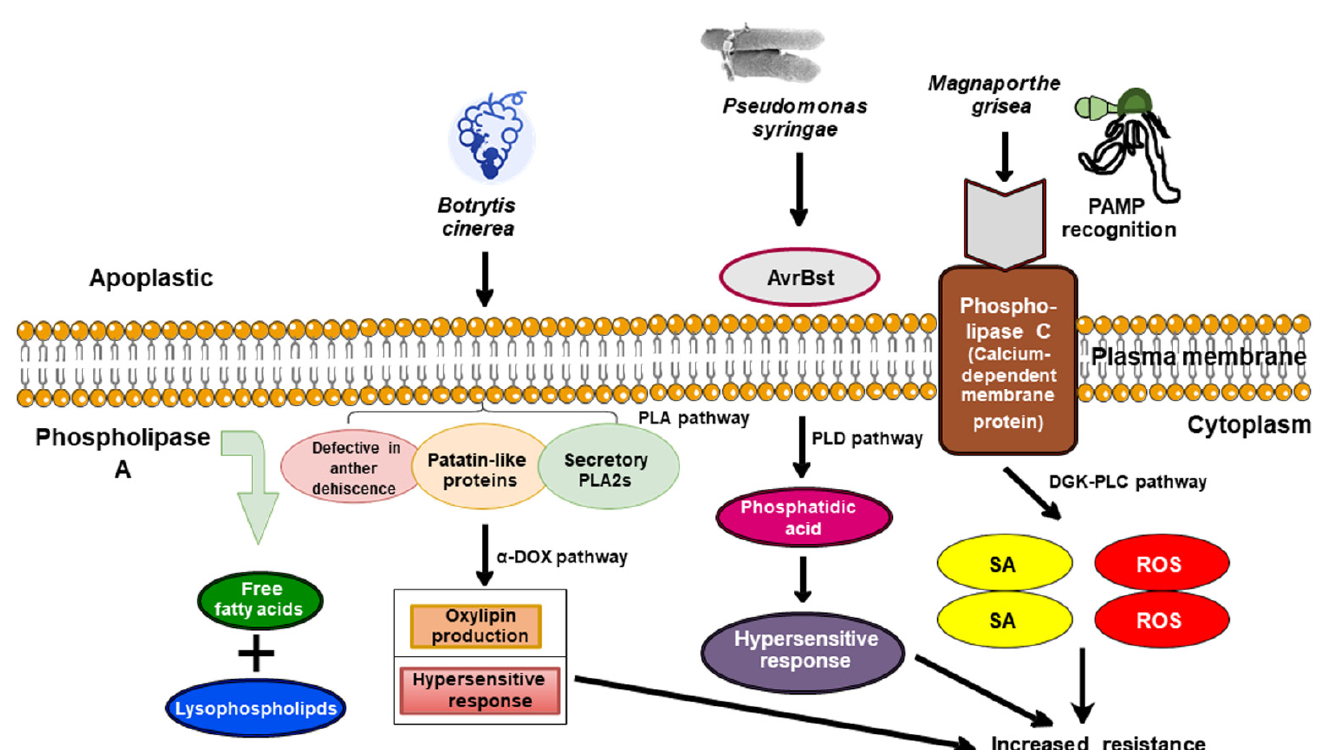
Figure 3. Surface signaling responses of hosts after the primary invasion of pathogenic species. During an immune response, the fundamental tenet is the ability to detect the presence of devastating agents (such as phytopathogens) followed by activating the defense responses. In plants, immunity is governed by transmembrane pattern recognition receptors (PRRs) and other downstream cellular components. These downstream immunity-related components include key enzymes— phospholipases—which draw much of our attention. PLAs are a superfamily of functionally diverse enzymes that actually govern membrane dynamics. The large superfamily of Phospholipases is divided into three sub-families: Phospholipase A (PLA), Phospholipase C (PLC), and Phospholipase D (PLD). These Phospholipases often hydrolyze various plasma membrane and intracellular membranes-derived phospholipids, phosphatidylinositol, and related-derivatives to generate signaling molecules such as phosphatidic acid, oxylipins, free fatty acids, and lysophospholipids as well as other molecules (inositol trisphosphate, diacylglycerol) that ultimately impart resistance against bacteria ( Pseudomonas syringae ) as well as fungi ( Botrytis cinerea and Magnaporthe grisea